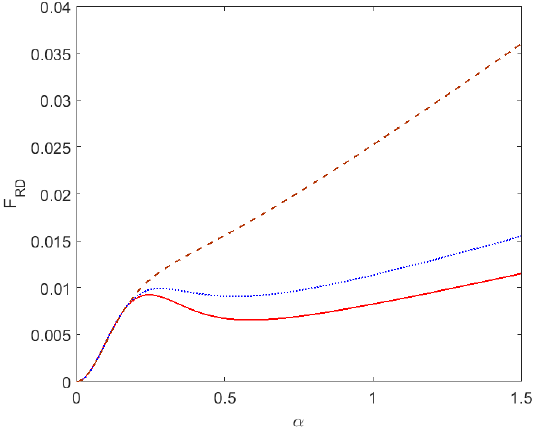
Figure 8. The Stark–Doppler absorption probability F RD for Rydberg radiative transitions in H-atoms as a function of pulse duration parameter α , detuning parameter δ = 5 and different ratio σ of Doppler to static widths: solid line − σ = 0, dotted line − σ = 1, dashed line − σ = 2.